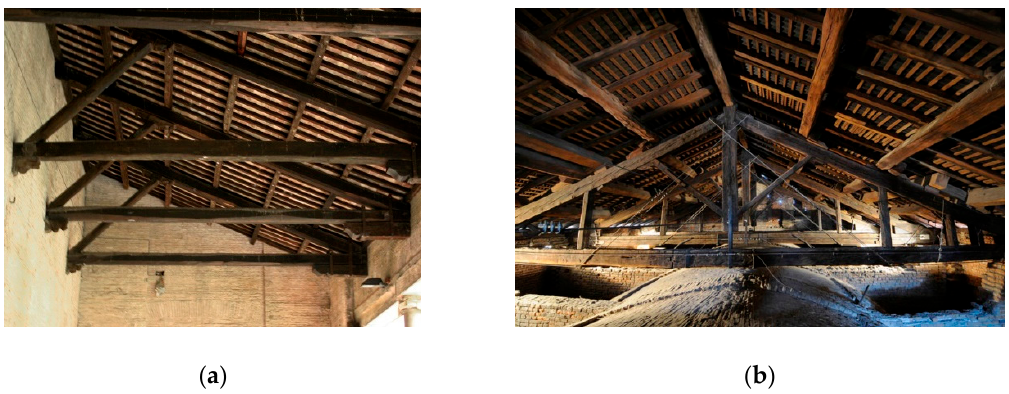
Figure 5. Different types of roof timber historic structures: ( a ) timber frame for a shed (skillion) roof; ( b ) traditional timber frame for a gable roof.